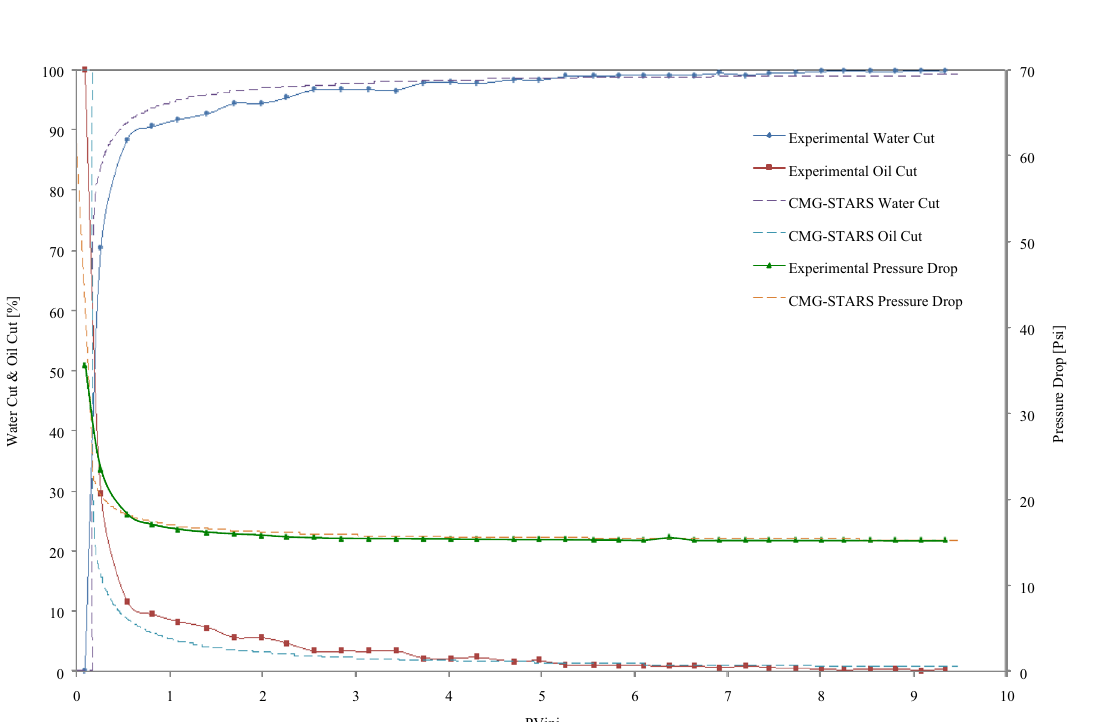
Fig. 10 History matching of the experimental and simulation water cut, oil cut, and pressure drop for pure